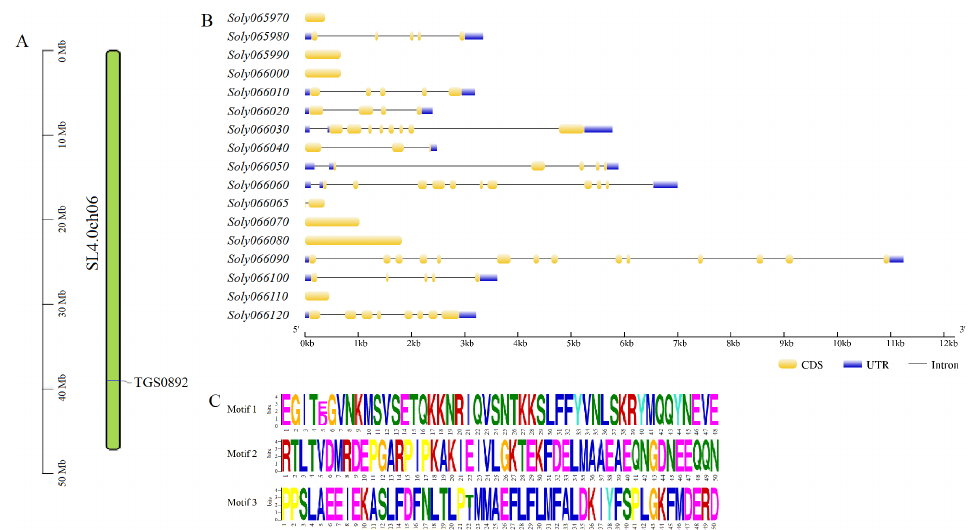
Figure 2. Chromosome position map of TGS0892 and analysis of upstream and downstream 50 kb gene structure in tomato. ( A ) Chromosome position map of TGS0892 molecular marker; ( B ) Gene structure analysis; ( C ) Motif analysis. Table 2. Analysis of properties of the genes and encoding amino acid sequences within 50 kb up- stream and downstream of TGS0892 in tomato.